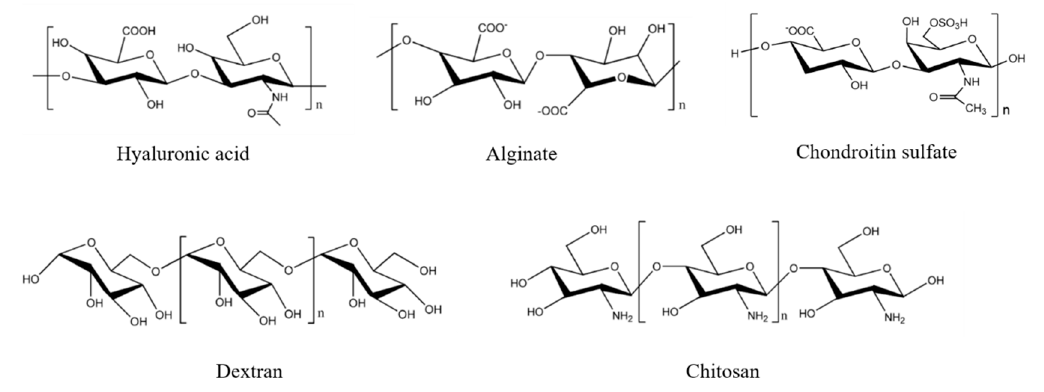
Figure 5. Structures of representative polysaccharides.